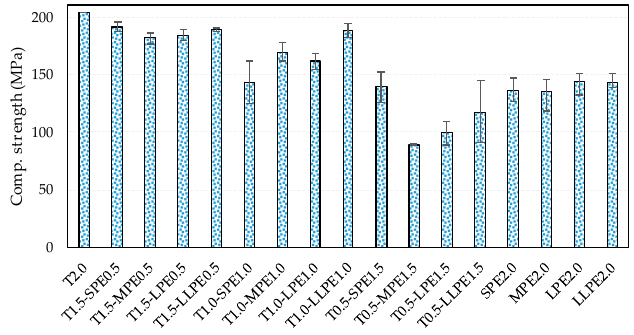
Figure 2. Compressive strength test results.